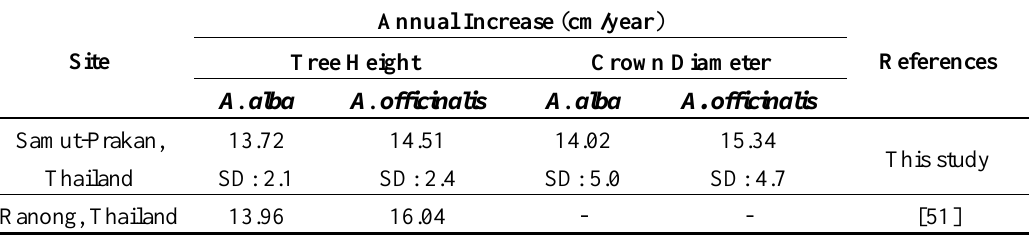
Table 3. Annual increase in Avicennia ( A .) alba and officinalis tree height and crown